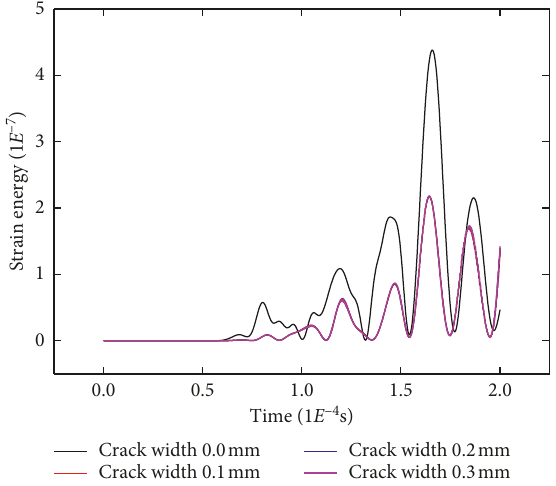
Figure 24: Strain energy of Sample 6.